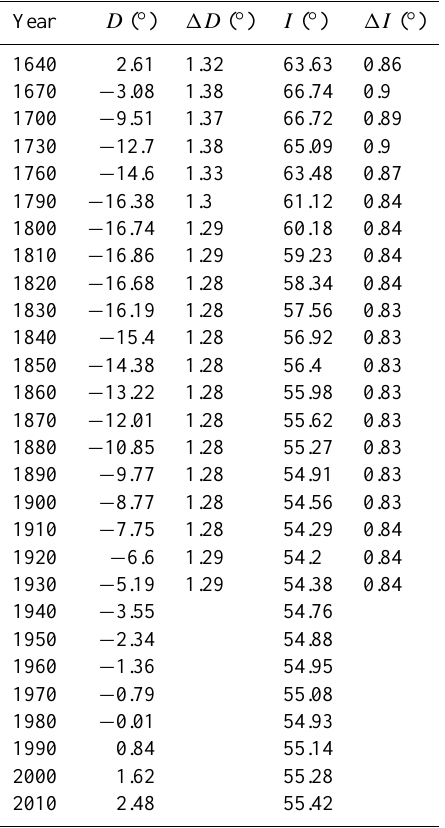
Table 1. Mean directions calculated by means of a 9th polinomyal degree interpolation after having relocated all Italian data to Strom- boli (38.8 ◦ N, 15.2 ◦ E) via the pole method, and having systemati- cally increased declination values of the Castellaccio series (years 1933–1962) by 1.6 ◦ (see text).